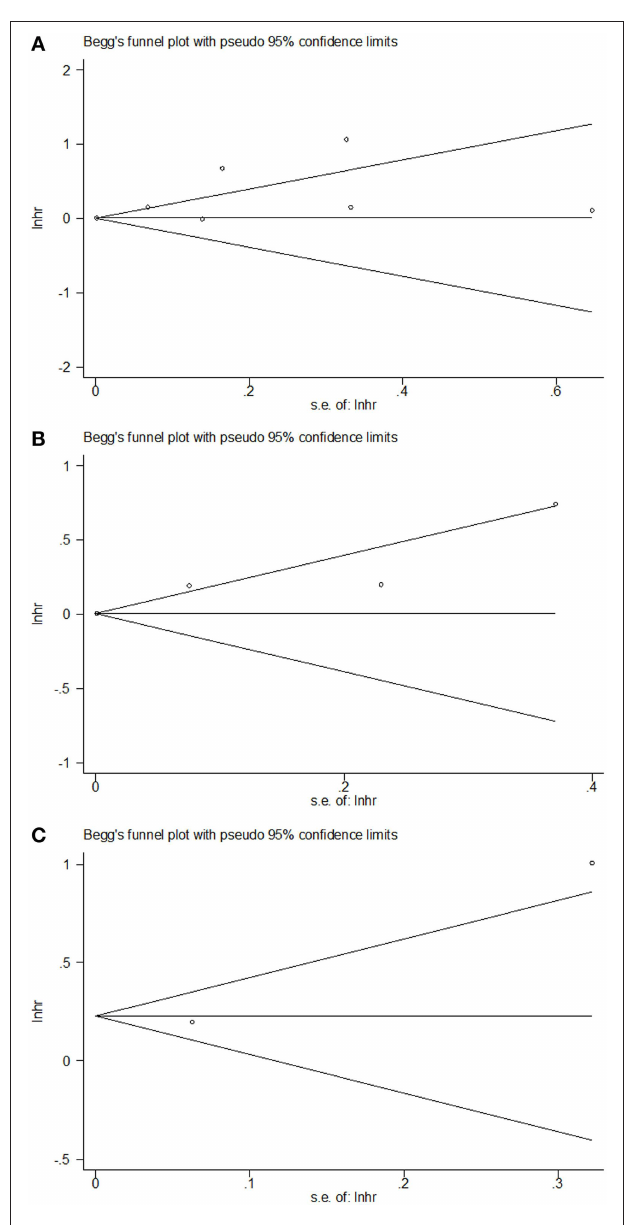
FIGURE 4 | Begg’s funnel plots of (A) OS, (B) CSS, and (C)